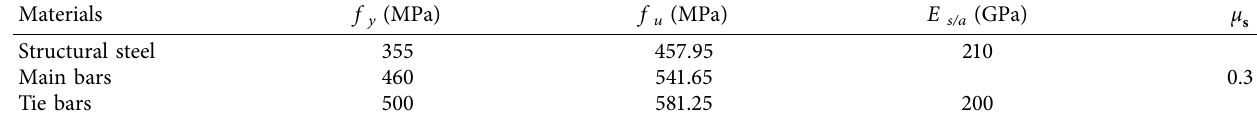
Table 1: Mechanical properties of the structural steel and rebar as per [16, 17].